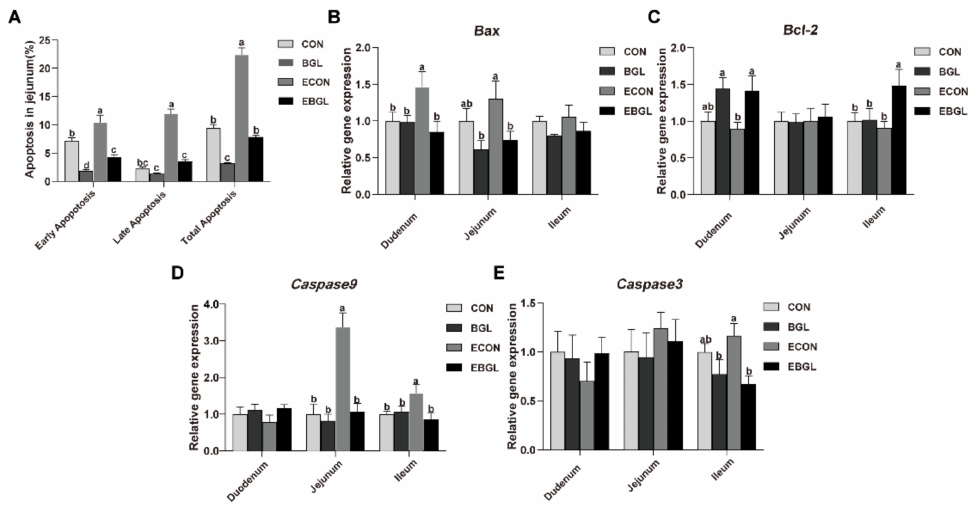
Figure 3. Effects of BGL on the percentage of apoptotic cells ( A ) and the relative expressions of related genes ( B – E ) in the small intestine of weaned pigs upon ETEC challenge. a, b, c, values within a row with different superscript letters are significantly different ( p < 0.05). CON, pigs were fed with a basal diet; BGL, pigs were fed with a BGL-containing diet (500 mg/kg); ECON, pigs were fed with a basal diet and challenged by ETEC; EBGL, pigs were fed with a BGL-containing diet and challenged by